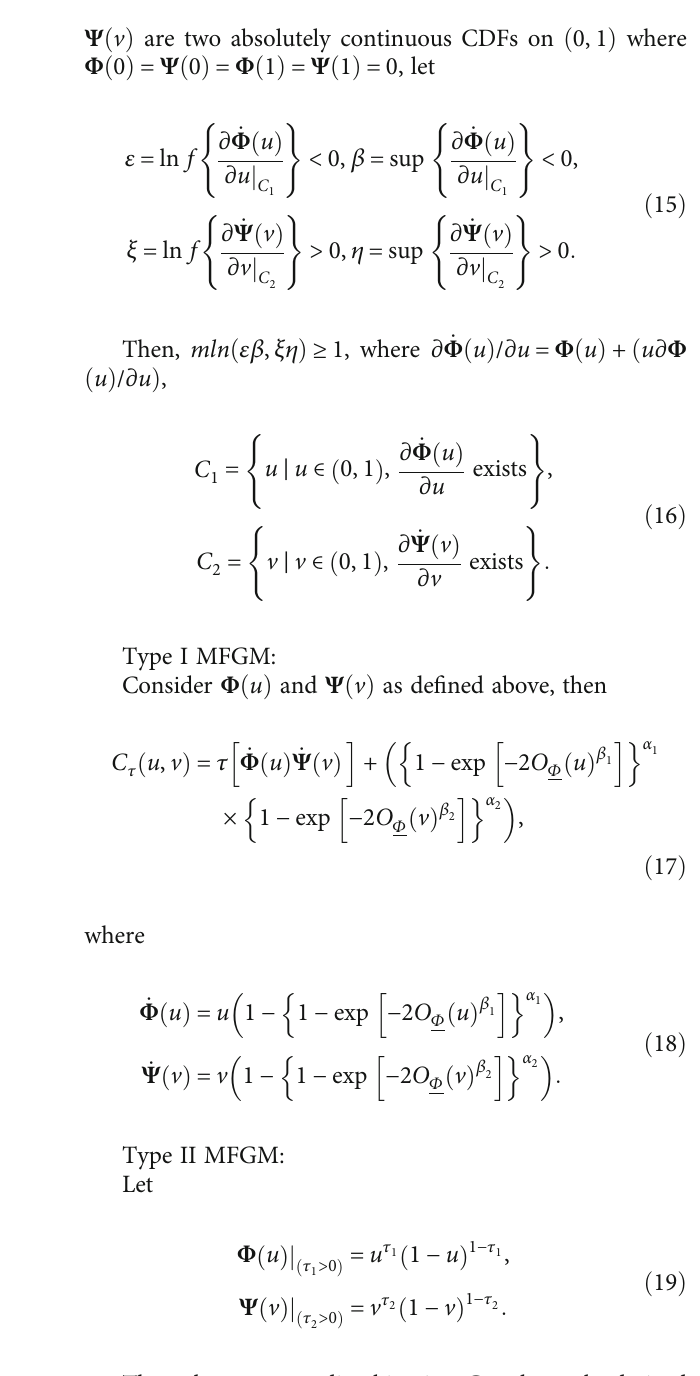
Figure 5: Biases and MSEs for the parameter θ